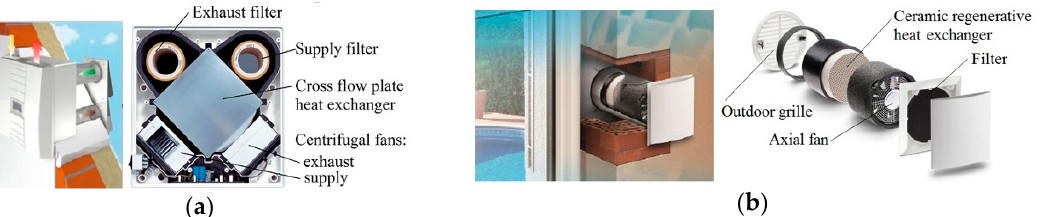
Figure 1. Types of room-based ventilation units used in the renovation of old apartment buildings: ( a ) with recuperative cross-flow plate HEX and ( b ) with regenerative ceramic heat exchanger (HEX).